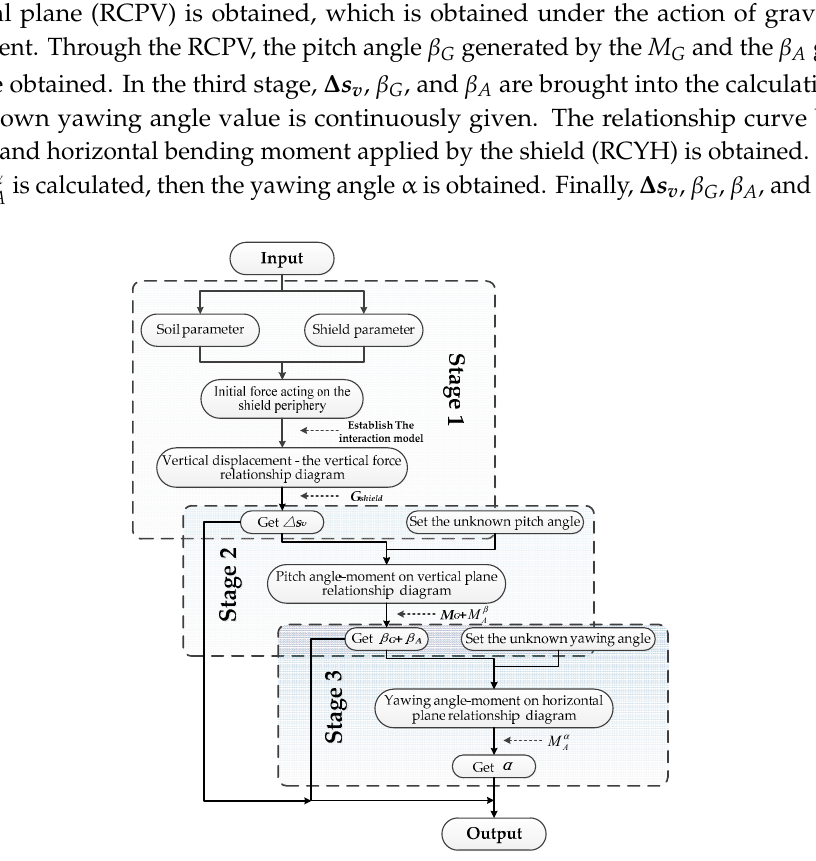
Figure 11. Shield attitude calculation flow chart.